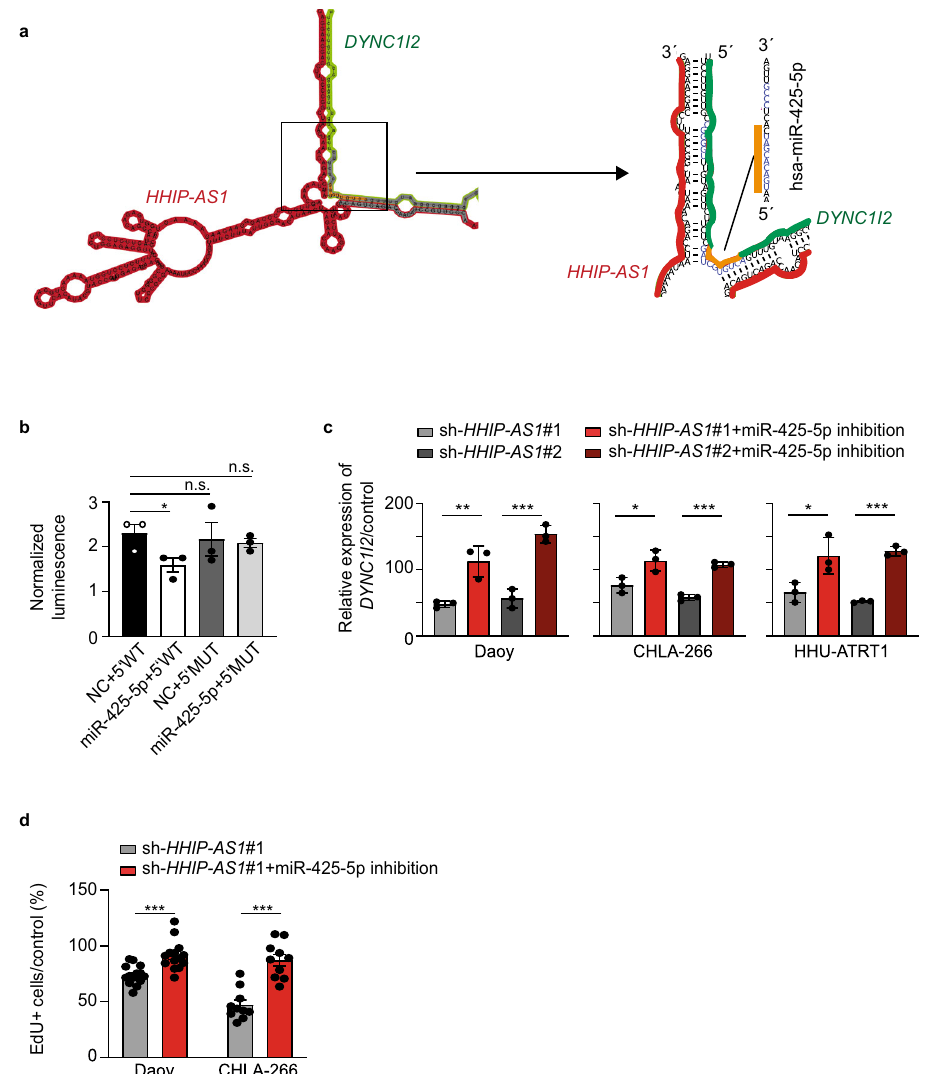
Fig. 5 HHIP-AS1 blocks endogenous hsa-miR-425-5p function to maintain DYNC1I2 levels. a Schematic view of the complex structure generated by the predicted base-pairing interaction between HHIP-AS1 (red) and the 5'UTR of DYNC1I2 mRNA (green). The sequence of hsa-miR-425-5p is also shown and the inferred binding site of this miRNA on DYNC1I2 mRNA 5'UTR is depicted in orange. The scheme highlights how this miRNA-mRNA interaction is predicted to be blocked by HHIP-AS1 association to DYNC1I2 mRNA. Black frame indicates position for zoom out image on the right side. b The wild type 5'UTR of DYNC1I2 mRNA (5'WT) or a mutated version (5'MUT) were cloned in front of a luciferase coding sequence and co-transfected in combination with hsa-miR-425-5p mimics (mir-425) or negative controls (NC) into Daoy cells. Bar graphs indicate the measured relative luciferase activity for each combination ± SEM in three independent experiments. Student ’ s one-sided t -test; * p < 0.05. n.s. not signi fi cant. c DYNC1I2 expression level was measured via qRT-PCR in Daoy, CHLA-266 and HHU-ATRT1 cells upon stable HHIP-AS1 knockdown using two independent stable shRNAs (sh- HHIP-AS1 #1 and sh- HHIP-AS1 #2), in combination with or without transient inhibition of hsa-miR-425-5p. Bar graphs are presented as the mean ± SD of three independent experiments. d Proliferation rate of Daoy and CHLA-266 with stable knockdown of HHIP-AS1 (sh- HHIP-AS1 #1) measured by EdU incorporation in combination with or without transient inhibition of hsa-miR-425-5p. Bar graphs are presented as the mean ± SEM of at least ten independent experiments and corresponding controls were set to 100%. Student ’ s two-sided t -test; *** p < 0.001; ** p < 0.01; * p < 0.05; n.s. not signi fi cant. Source data and exact p - values are provided as a “ Source Data fi le ”